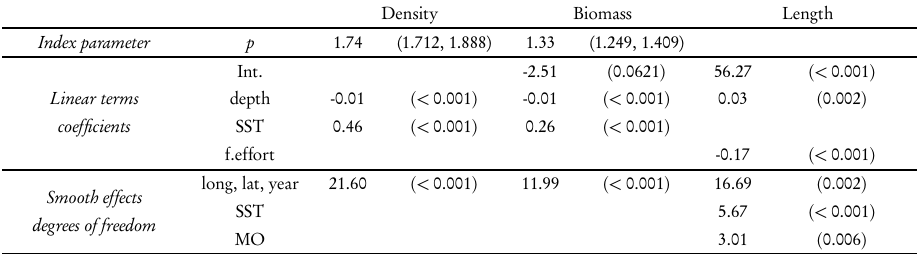
Model estimates for Aristaemorpha foliacea